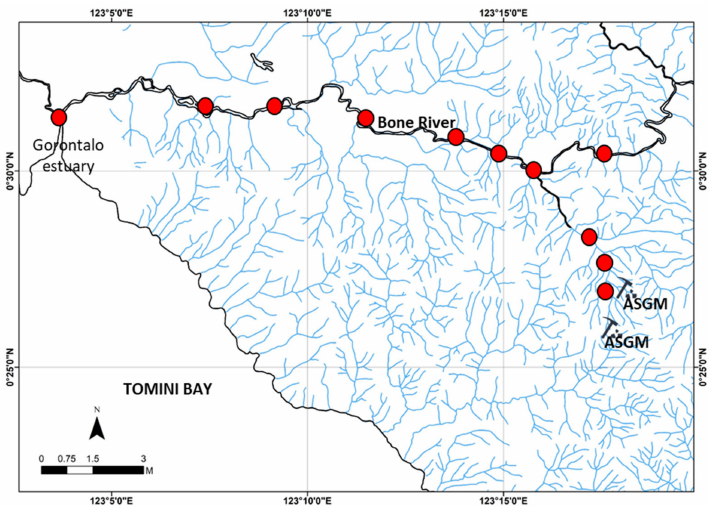
Figure 2. Water and sediment sampling points from the upper course to the lower course of Bone River.